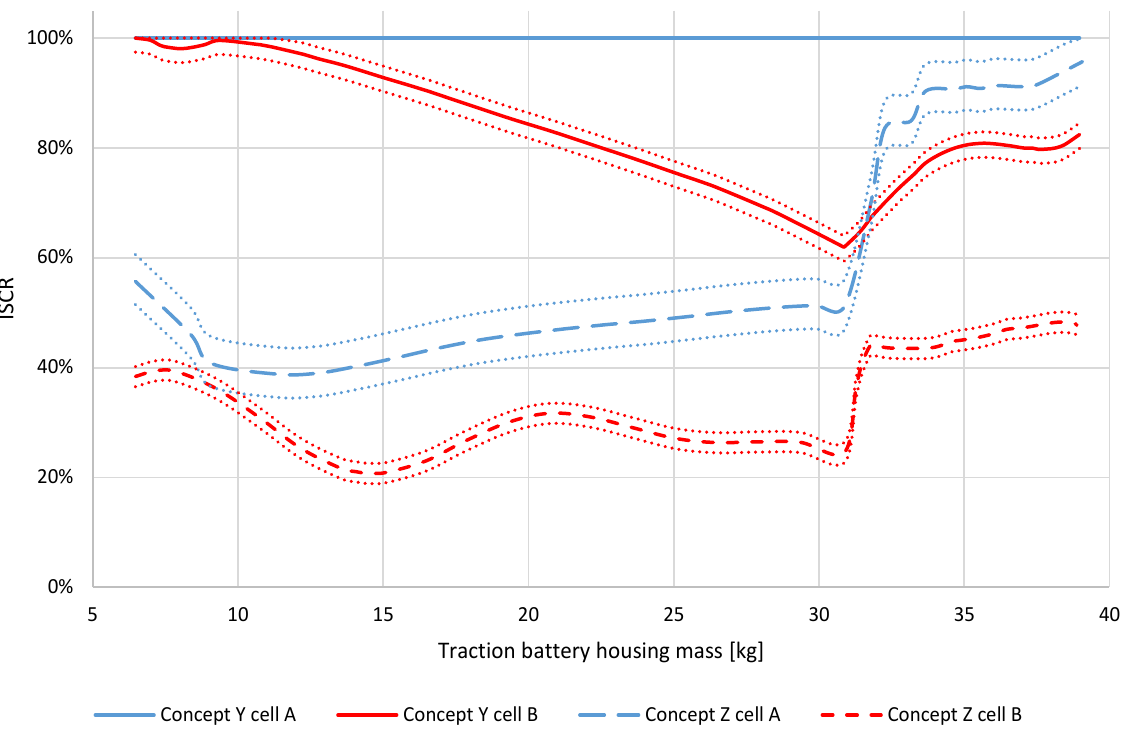
Figure 8. Comparison of ISCR and mass trends for Concepts Y and Z with cells A and B. The dotted lines represent the upper and lower limit of the TR for each metamodel.